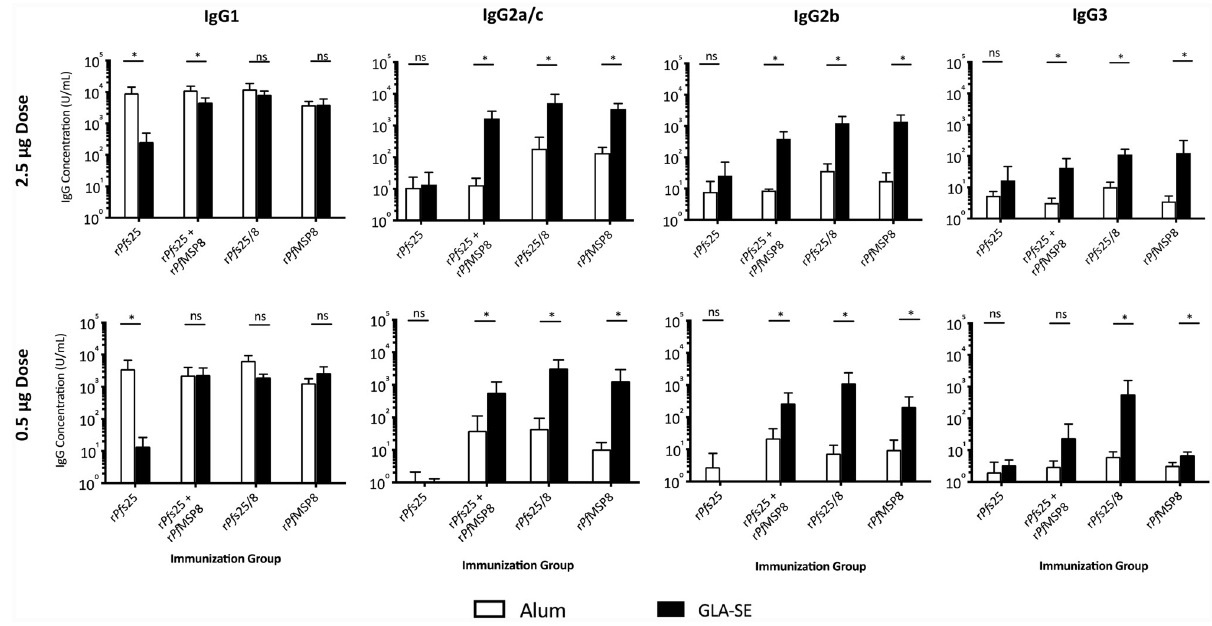
Fig 6. Profile of IgG subclasses of vaccine-induced IgG is dependent upon adjuvant and antigen. CB6F1/J sera harvested four weeks following the final immunization were analyzed for relative levels of the indicated IgG subclasses by ELISA using plates coated with r Pf s25/8 (0.25 μ g/well). Graphs depict the mean IgG subclass concentration +/- standard deviation. Comparisons of two groups that differed by adjuvant only were conducted and asterisks over horizontal lines indicate significant differences between groups (Mann-Whitney U Test; P < 0.05 considered significant; ns, not significant).